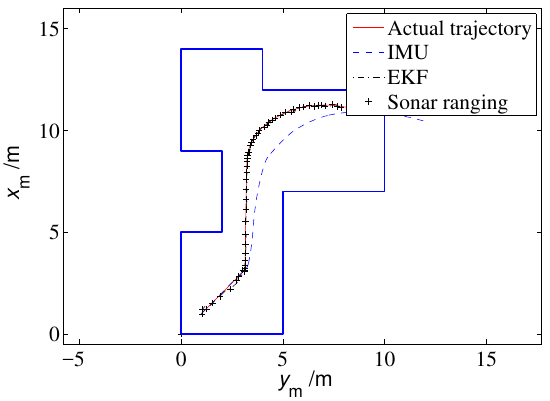
Figure 11. Localization results (simulation).